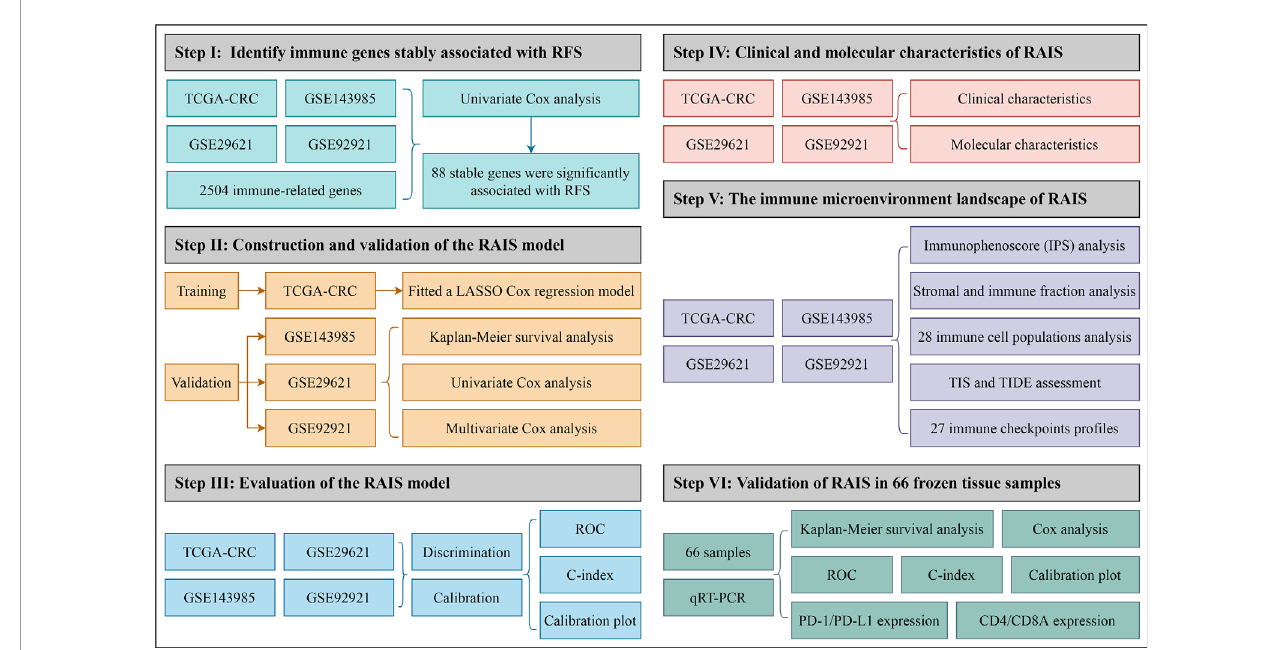
FIGURE 1 | The fl owchart of this